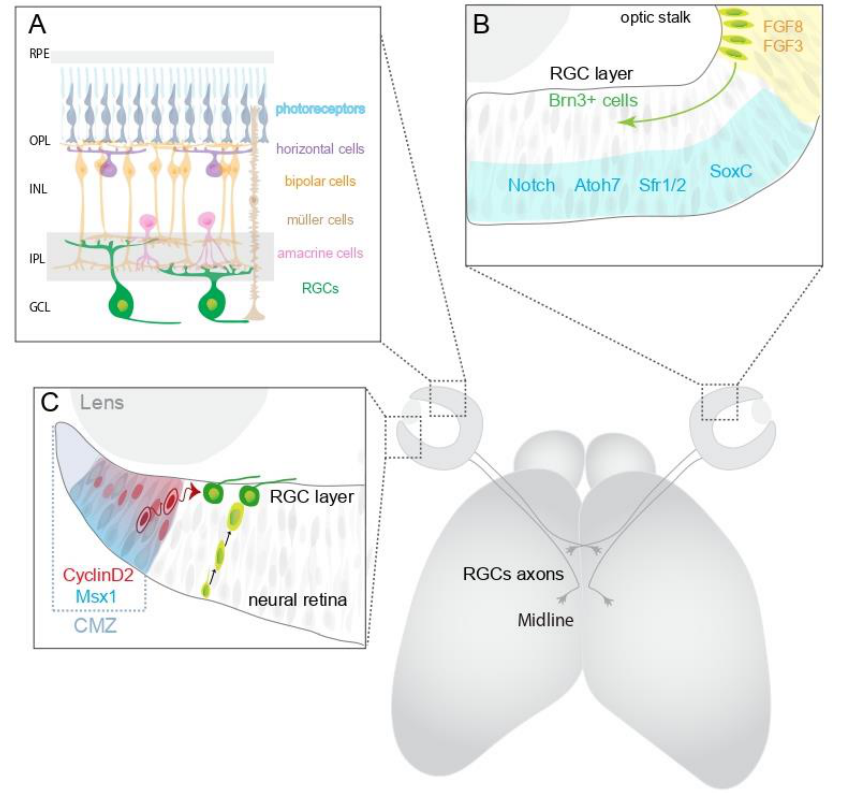
Figure 1. ( A ) Organization of the retina. All visual information regarding the outside world reaches the brain through the retina, which is composed of 3 layers of cells and two layers made up of connections between these cells. From inside to outside these are: the ganglion cell layer (GCL), containing nuclei of RGCs and displaced amacrine cells; the inner plexiform layer (IPL) where synapses between the bipolar cell axons and the dendrites of the ganglion and amacrine cells take place; the inner nuclear layer (INL), containing the nuclei and cell bodies of the bipolar, horizontal, and amacrine cells as well as Müller glial cells; the outer plexiform layer (OPL) where the projections of rods and cones are located and synapse with dendrites of bipolar and horizontal cells, and the outer nuclear layer (ONL), containing the cell bodies of the rods and cones which are the light detectors. The outer segments of photoreceptor cells associate with the retinal pigmented epithelium (RPE). ( B ) Transcription factors are expressed in the progenitor cells of the embryonic retina and regulate retinal neurogenesis and cell fate specification. ( C ) Regulated by Msx1 and CyclinD2, progenitor cells from the ciliary margin zone (CMZ), at the periphery of the retina, can proliferate and differentiate into all seven major retinal cell types, including ipsilaterally and contralaterally projecting RGCs.